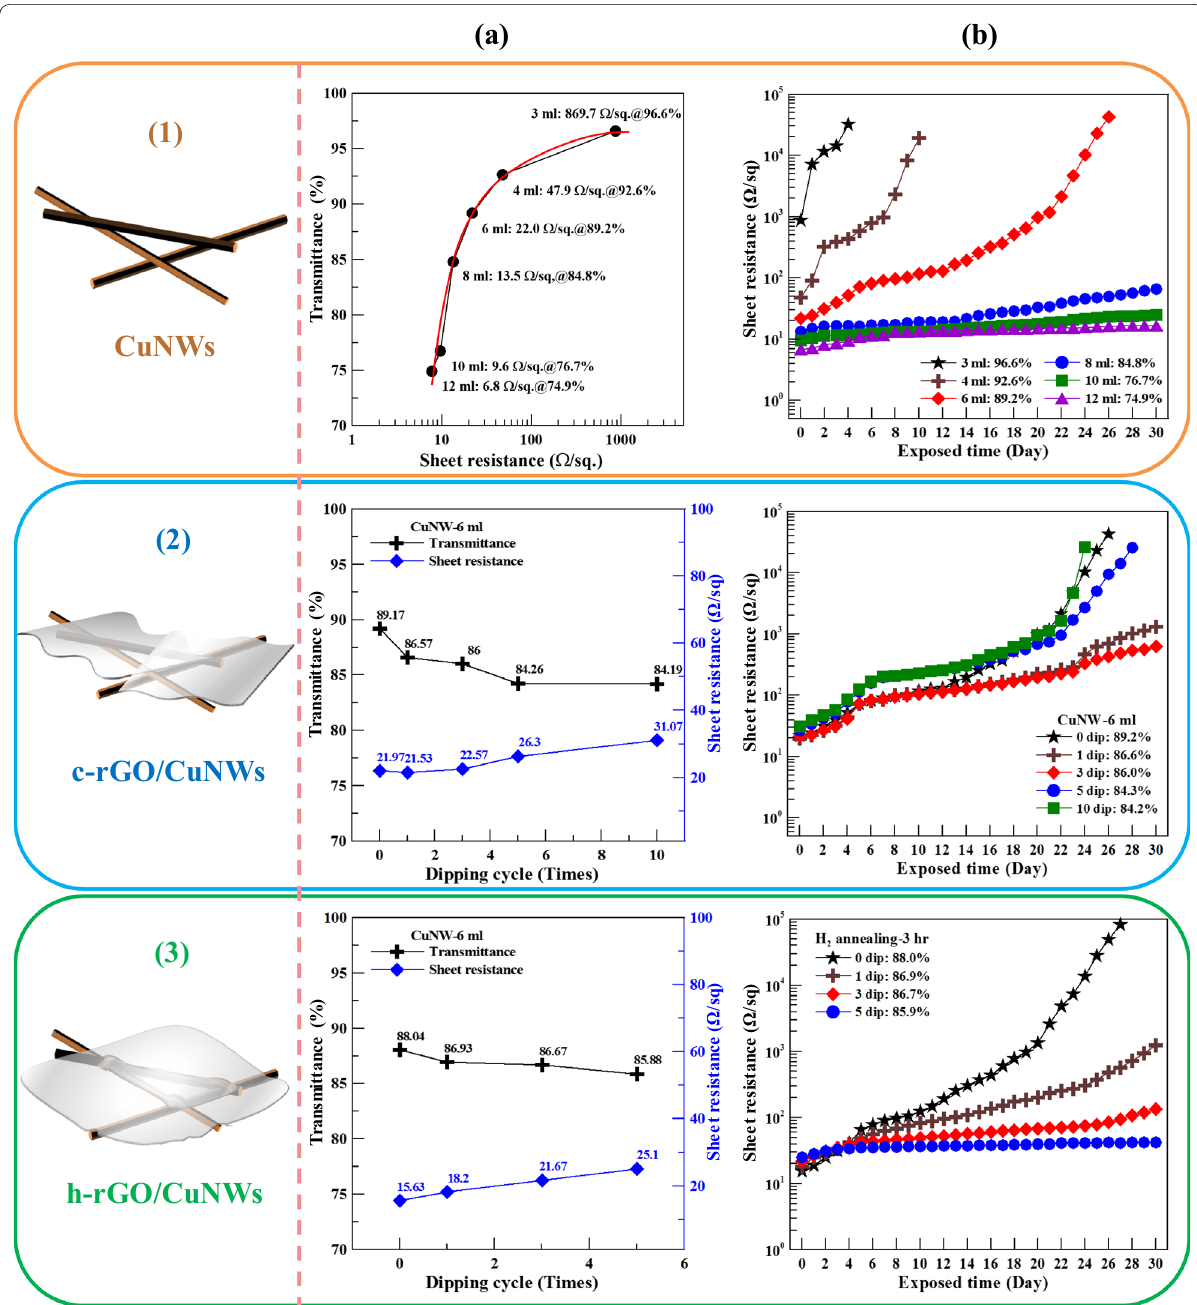
Fig. 4 Schematic illustration of (1) CuNWs, (2) c‑rGO/CuNWs films, and (3) h‑rGO/CuNWs films. Column a optical transmittance versus sheet resistance and b variations of the sheet resistance versus exposed